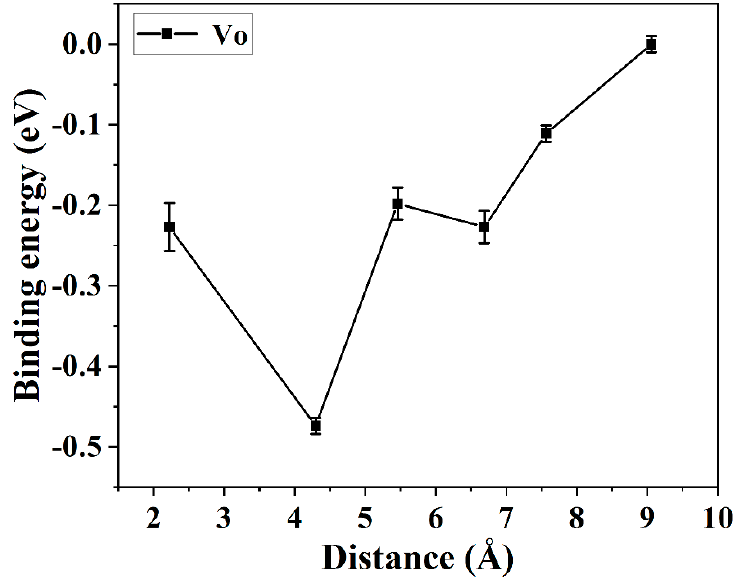
Figure 8. The binding energy between Y 3+ and V O with respect to the ionic